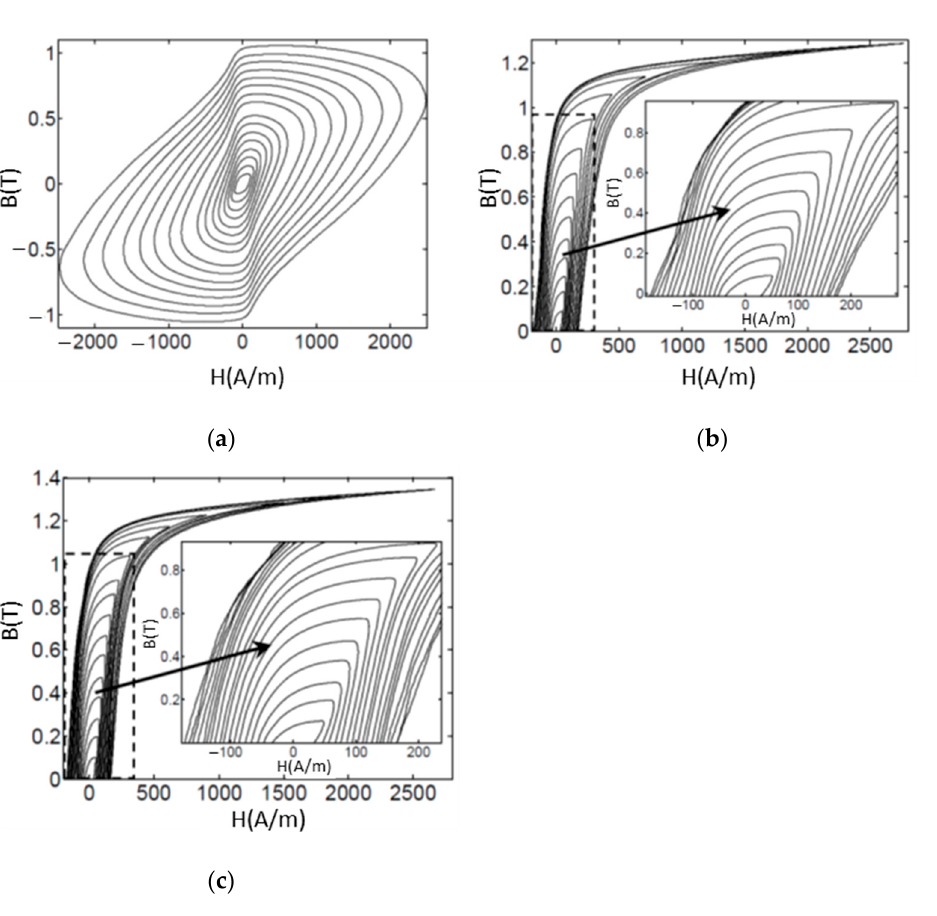
Figure 12. Dynamic hysteresis loops at 50 Hz, samples FeSi3, ( a ) sample with full-section; ( b ) sample with optimized Section 1; ( c ) sample with optimized Section 2.